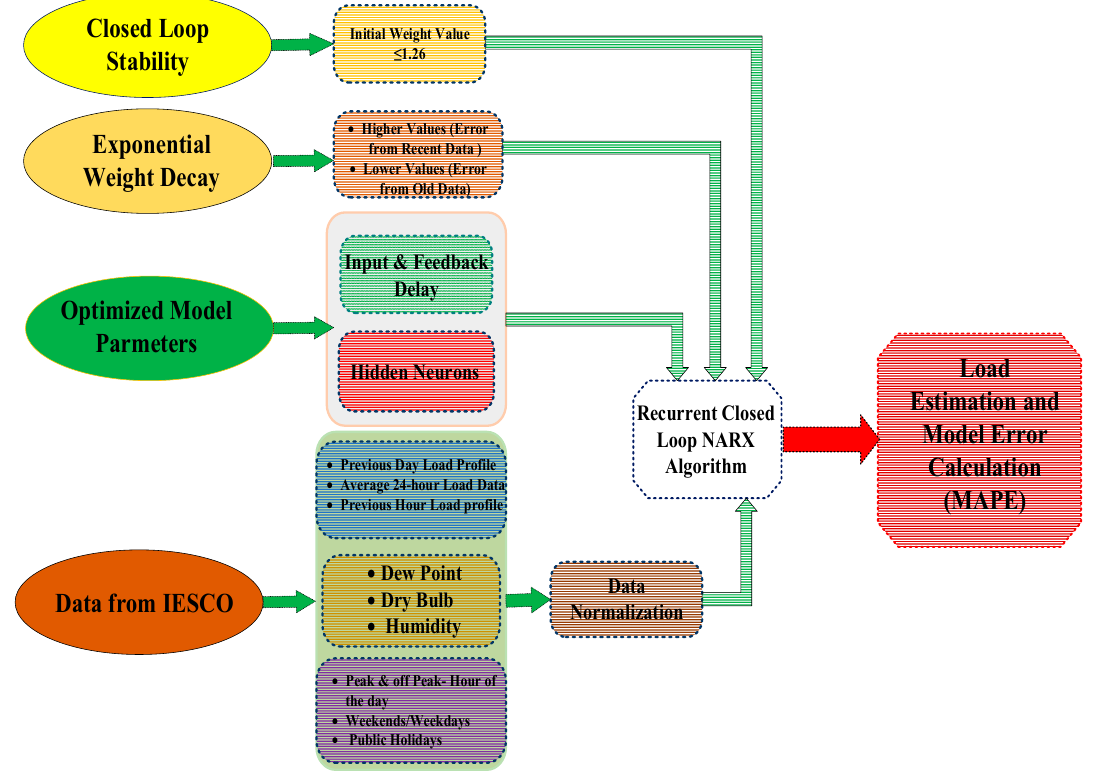
Figure 10. Proposed network